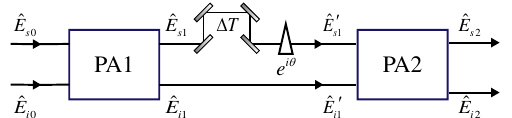
FIG. 3. An unbalanced SU(1,1) interferometer with two pulse- pumped parametric amplifiers (PA1,PA2). Compared to the idler field [ ˆ E im ( m = 0, 1, 1 (cid:6) , 2 ) ], signal field [ ˆ E sm ( m = 0, 1, 1 (cid:6) , 2 ) ] has an extra delay of (cid:3) T , which is the separation between